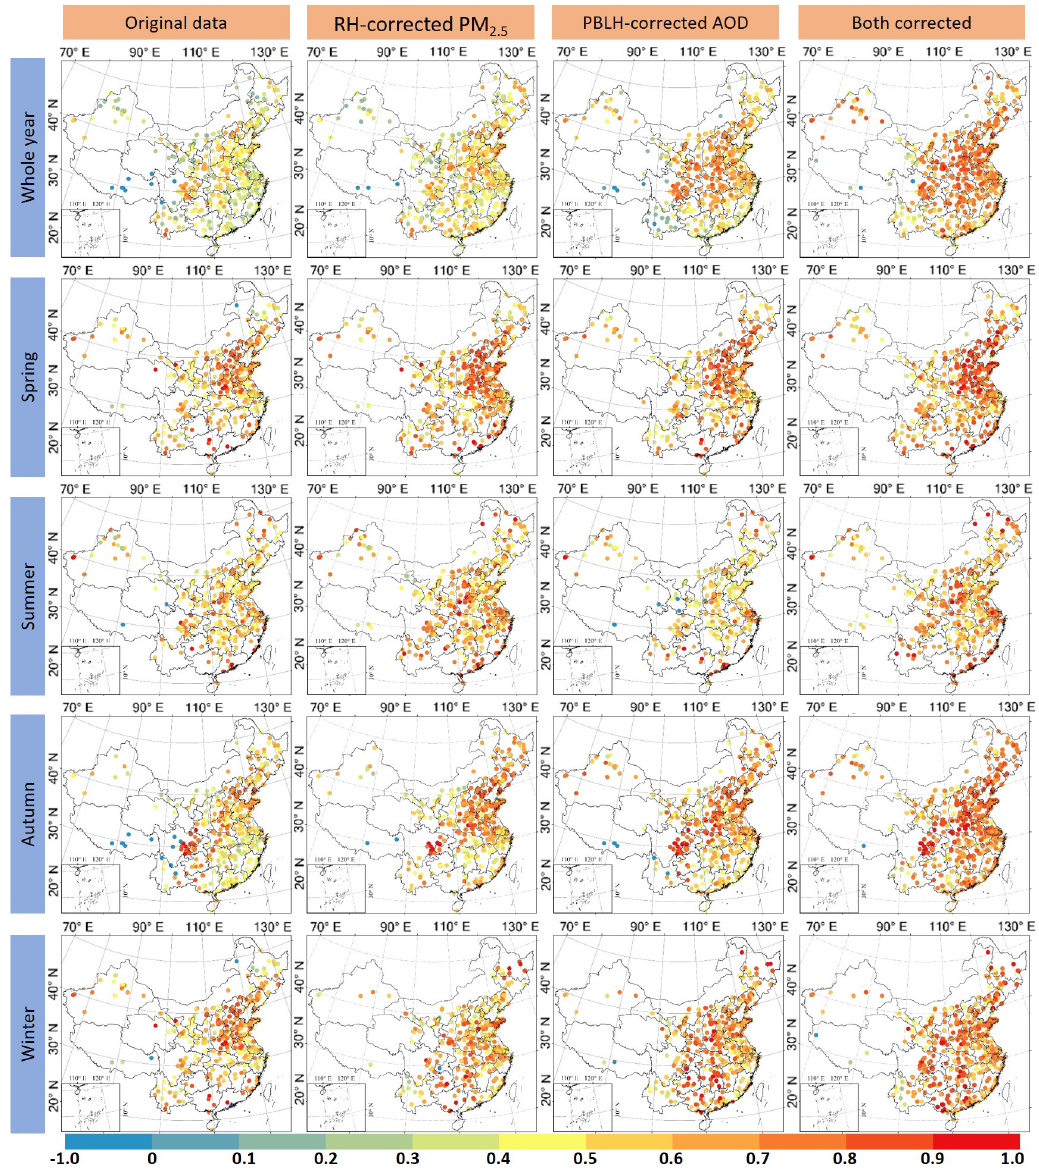
Figure 6. The relationship between PM 2 . 5 and AOD in China for the entire year 2019 and for each respective season based on the original PM 2 . 5 and AOD observations (left column), only PM 2 . 5 corrected by RH (middle left column), only AOD corrected by the PBLH (middle right column) and both corrected data (right column). Please note that only stations with statistically significant results (i.e., p level < 0.5) are presented in this